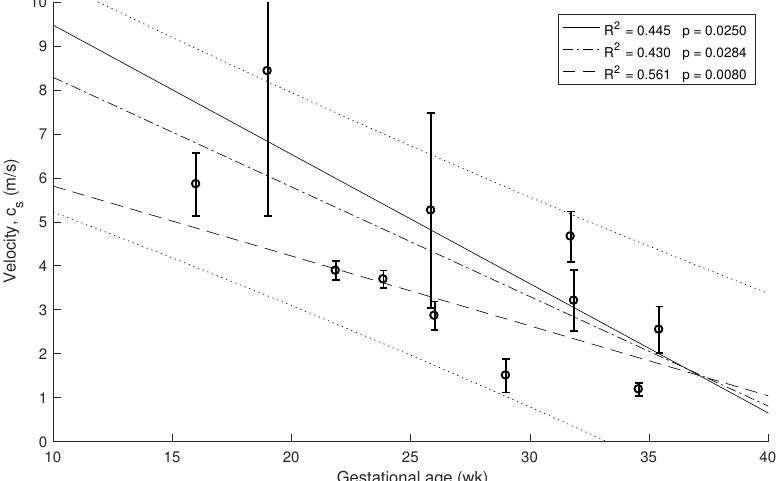
Figure 6. Relationship between cervical stiffness assessed by shear wave speed using 1.5 kHz waves and gestational age at time of examination.